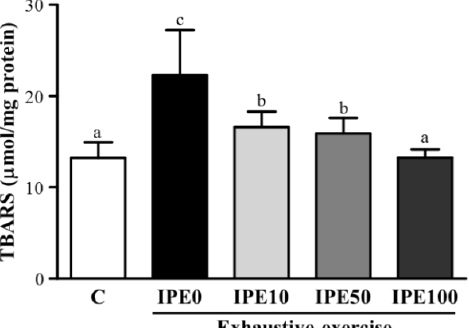
Figure 2. Effect of I. parviflora extract (IPE) supplementation on the hepatic thiobarbituric acid-reactive substance (TBARS) levels after an exhaustive swimming exercise